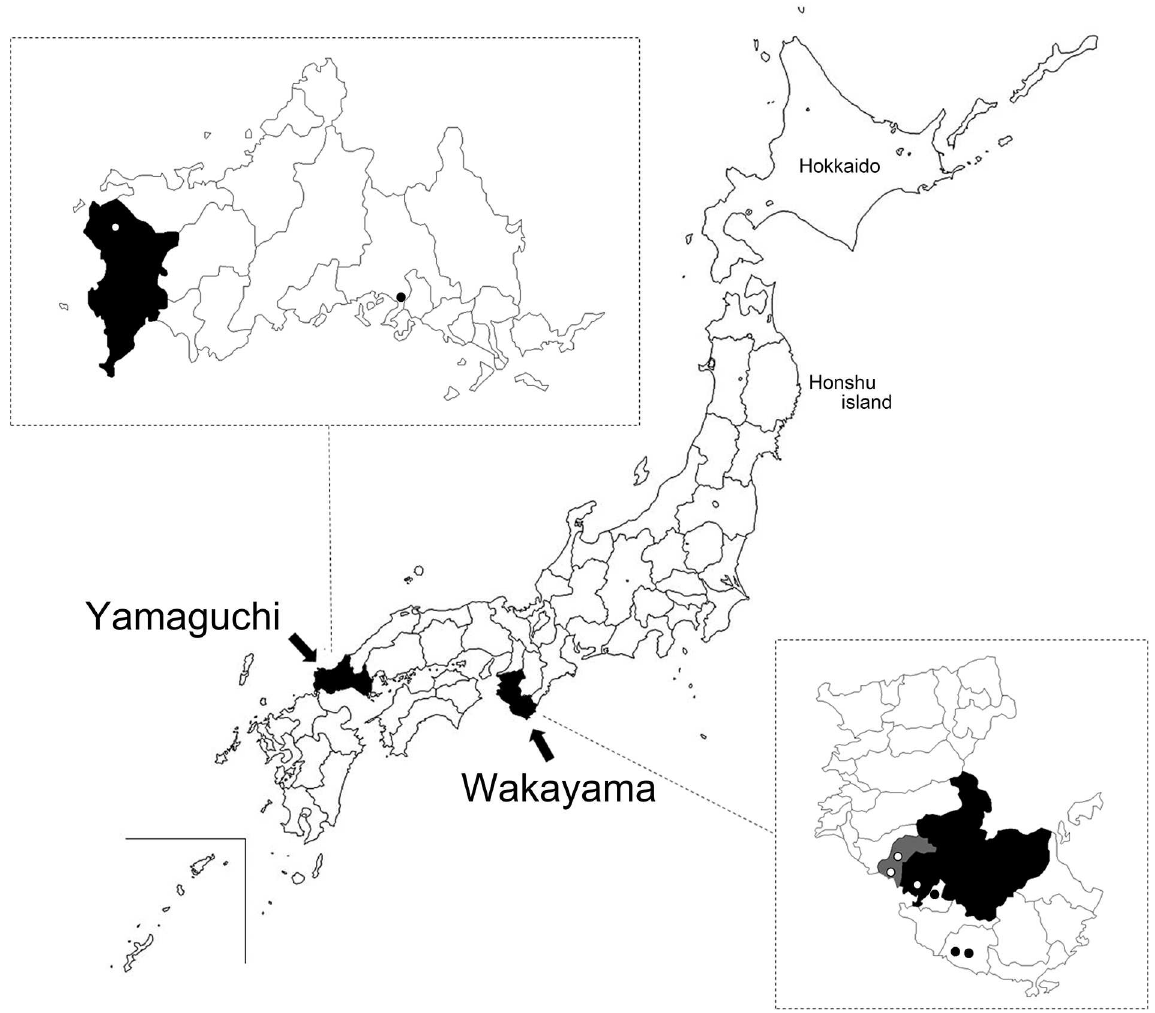
Fig 1. Collection sites. The gray and black shadingin the lower right large-scale map indicatesMinabetown and Tanabe City in Wakayama Prefecture, respectively.The black shadingin the upper left large-scalemap indicatesShimonoseki City in Yamaguchi Prefecture. The geographiclocations of the tick samplingsite are designatedby black or white dots. Reprintedfrom (http://www. freemap.jp/item/japan/japan1.html) under a CC BY license, with permissionfrom KeisukeInoue, originalcopyright2016.